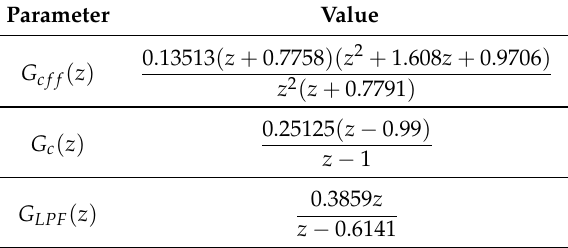
Table A3. Controller